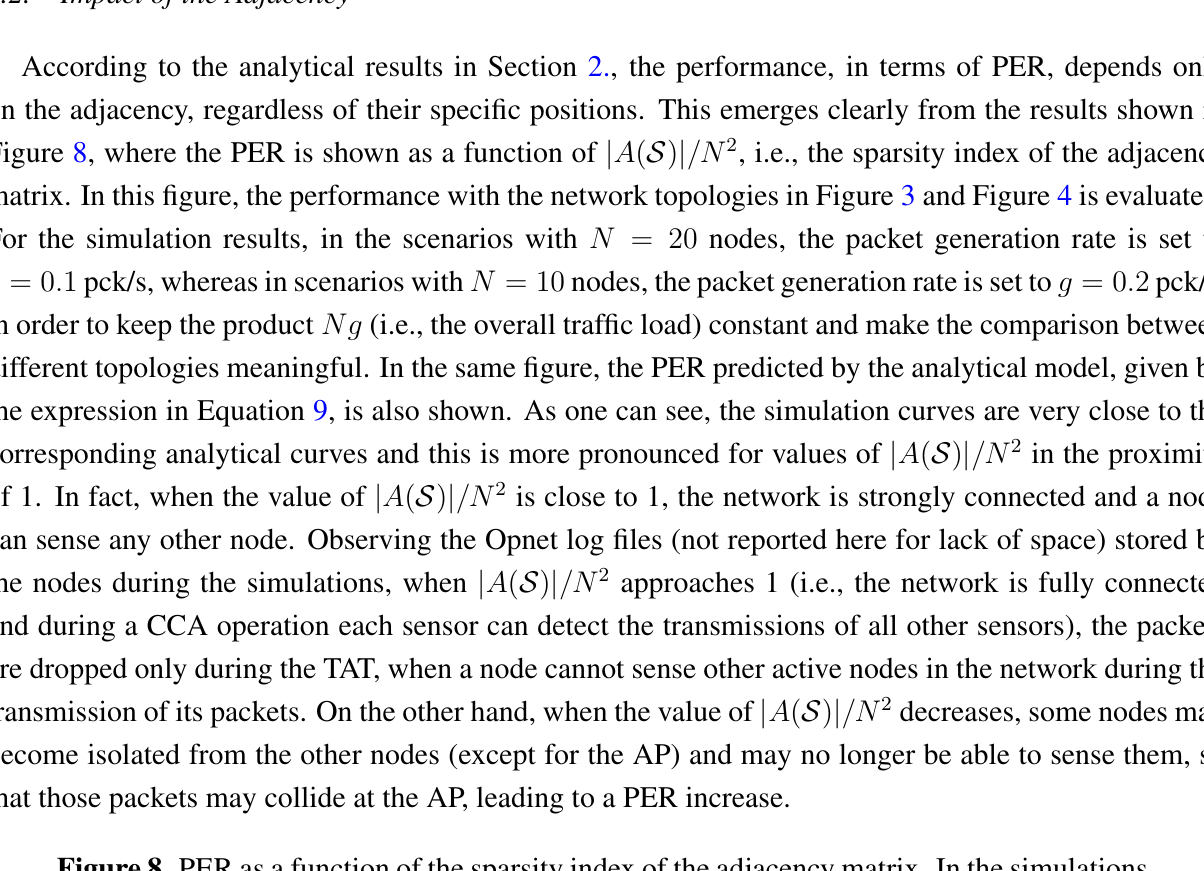
Figure 8. PER as a function of the sparsity index of the adjacency matrix. In the simulations, for scenarios with N = 20 nodes, the packet generation rate is set to g = 0 . 1 pck/s, whereas for scenarios with N = 10 nodes, the packet generation rate is set to g = 0 . 2